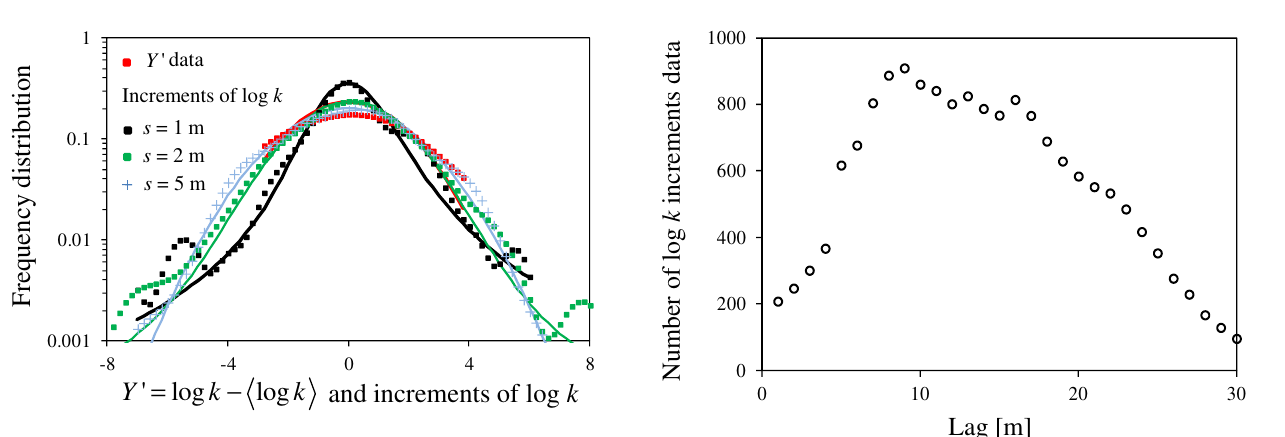
Fig. 6. Log-log variations of S q ≤ q ≤ 5. Solid lines represent indicated regression fits. Standard moment analysis would entail fitting straight